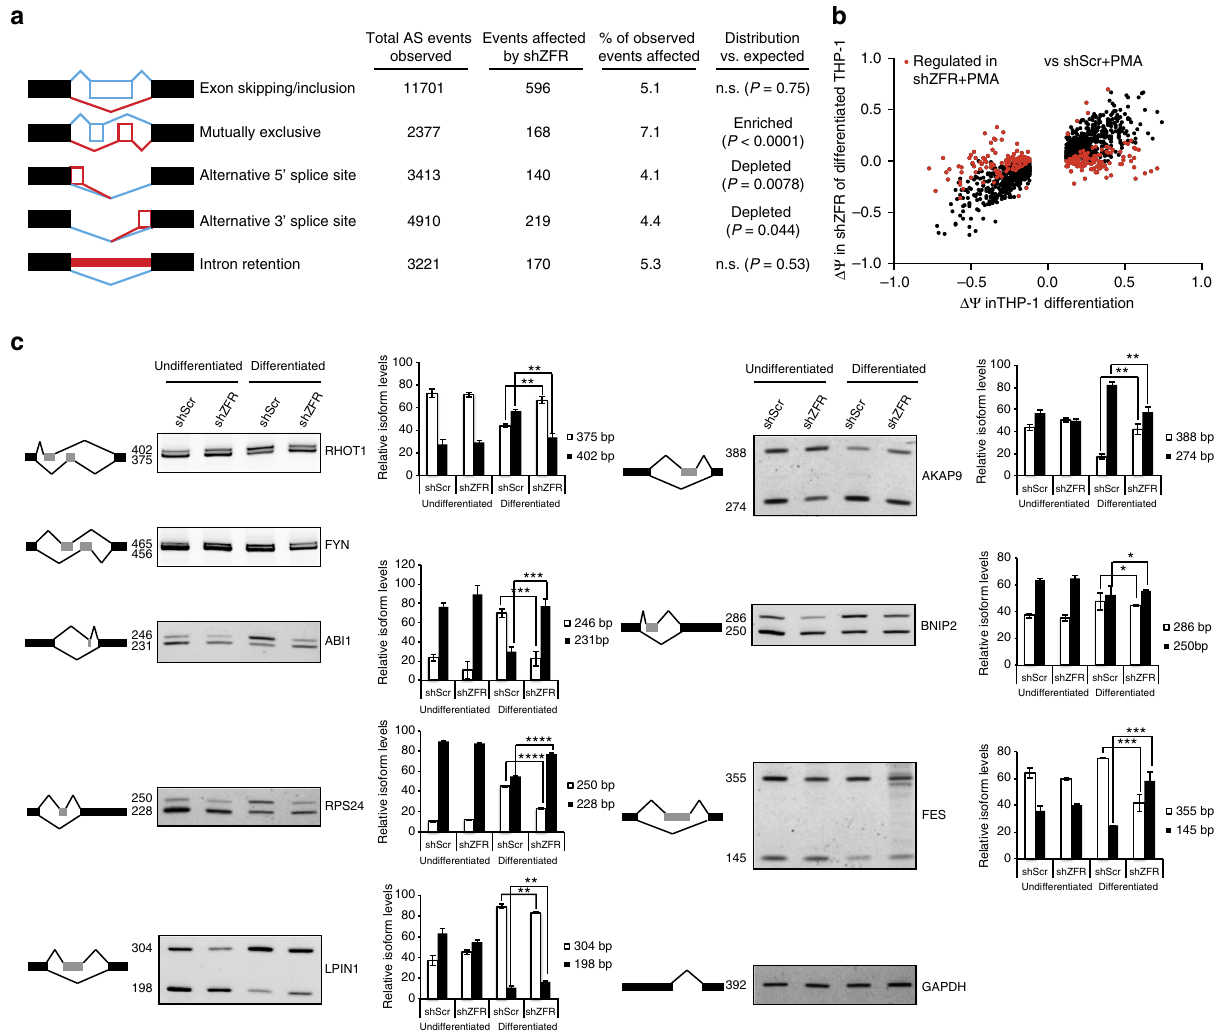
Fig. 4 ZFR regulates alternative splicing in THP-1 differentiation. a Table of alternative splicing events affected by ZFR knockdown in differentiated THP-1 cells. Numbers of total alternative splicing events meeting read coverage cutoffs and events signi fi cantly changed by ZFR knockdown in MISO analysis (bayes factor > 20 and | Δ Ψ | > 0.12) are indicated (see Methods for details). P values were derived from binomial tests of observed vs. expected frequencies. b Scatter plot of Δ Ψ values from comparisons of differentiated THP-1 cells treated with shScr and shZFR ( y -axis) and Δ Ψ values from comparisons of differentiated shScr THP-1 cells and monocytic shScr THP-1 cells ( x -axis). Events signi fi cantly changed (bayes factor > 20 and | Δ Ψ | > 0.12) upon ZFR knockdown are indicated in red. c RT-PCR of the indicated transcripts in monocytic and macrophage-like THP-1 cells treated with ZFR-speci fi c or control shRNAs, using primers fl anking exons found to be regulated by MISO analysis. Usage of each isoform was calculated as percent of total ( n = 3). Approximate MW based on size markers is shown. Graphs indicate mean ± SD; * P < 0.05, ** P < 0.01, *** P < 0.001, **** P < 0.0001 (two-tailed Student ’ s t - test). Co-migration of bands corresponding to mutually exclusive FYN isoforms precluded accurate quanti fi cation